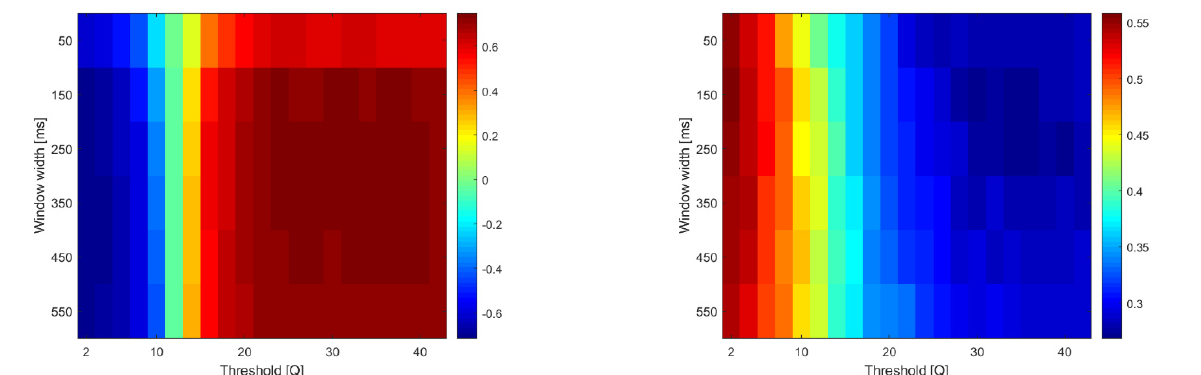
Figure 7. RMSE ( left ) and cross-correlation ( right ) for firing rate with different thresholds and window widths.